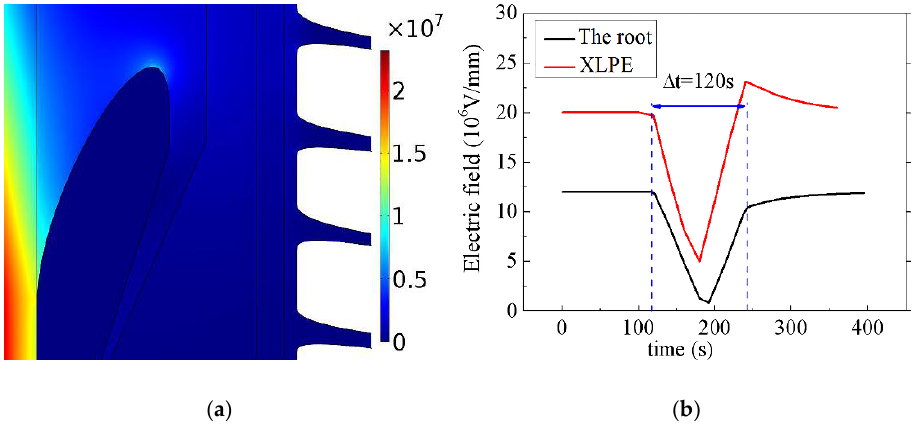
Figure 13. Electric field distribution inside the cable termination in the polarity reversal process: ( a ) When the applied voltage reaches-U TP1 ; ( b ) variation of the electric field strength with respect to time.